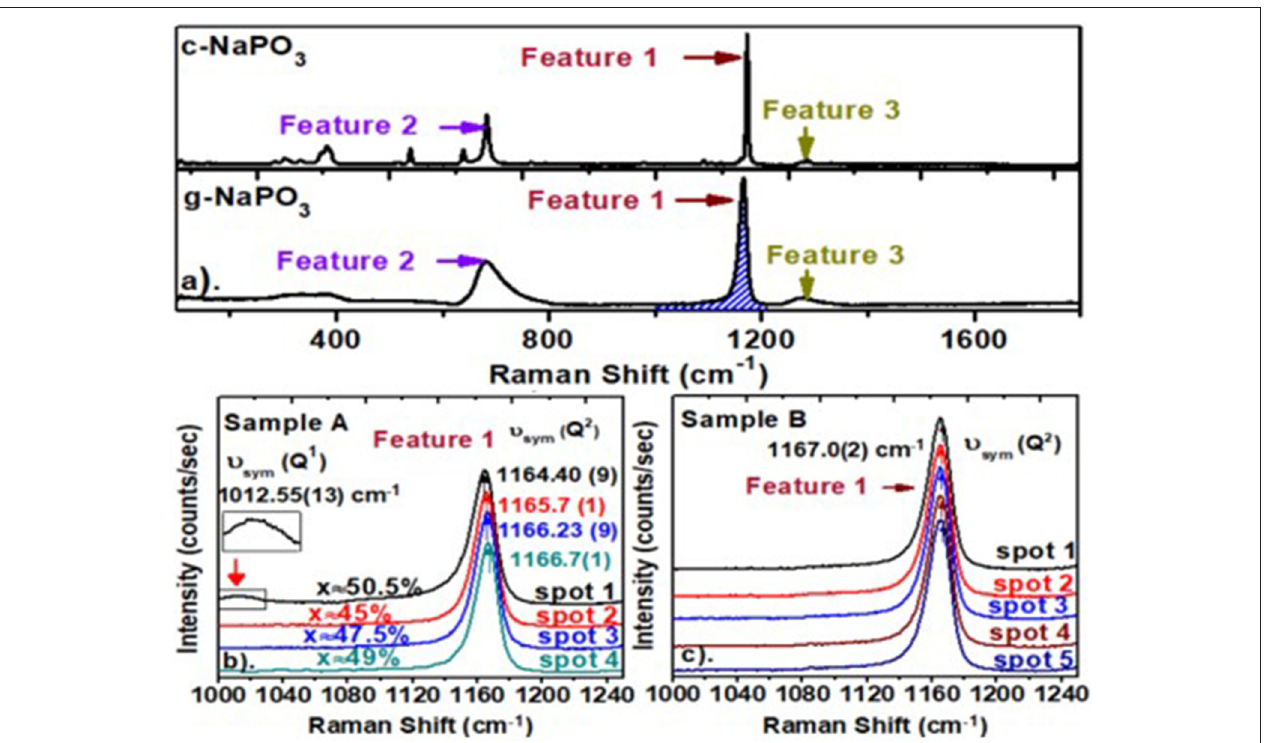
FIGURE 3 | (a) Raman scattering in c-NaPO 3 compared to the one in g- NaPO 3 . In the two panels below (a) , we compare the micro-Raman profiling of feature 1 in a glass from sample A (b) with the one of a glass sample B (c) . The results show the variance in x for sample A is 5.5%, but the variance in x for sample B is vanishing. In (b) , note that the Q 1 -related mode near 1,012 cm − 1 is observed at spot 1, showing the composition to be x = 50.5%. Global variation of feature 1 mode-width and mode-frequency of sample B appear in Figure 7A . Details of the glass synthesis appear in section Synthesis of (Na 2 O) x (P 2 O 5 ) 100 − x glasses.